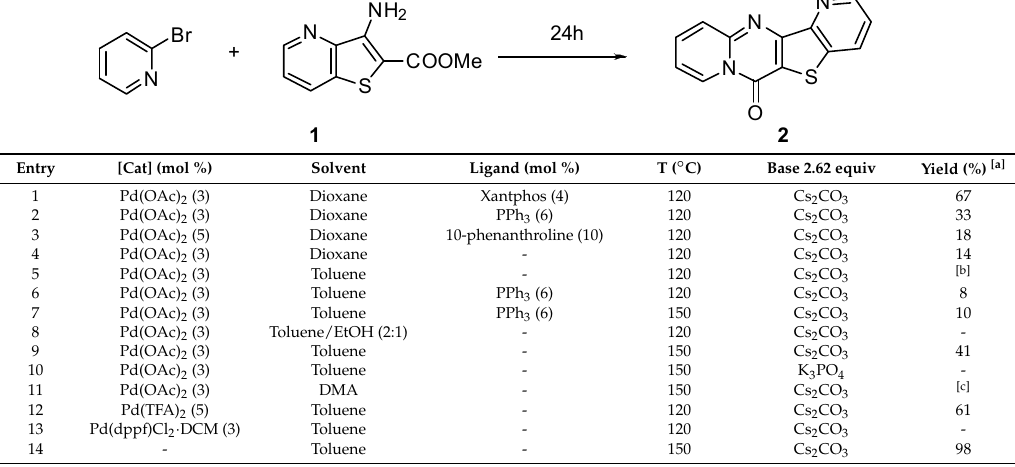
Table 1. Optimization of conditions to generate tetracyclic compound 2 .